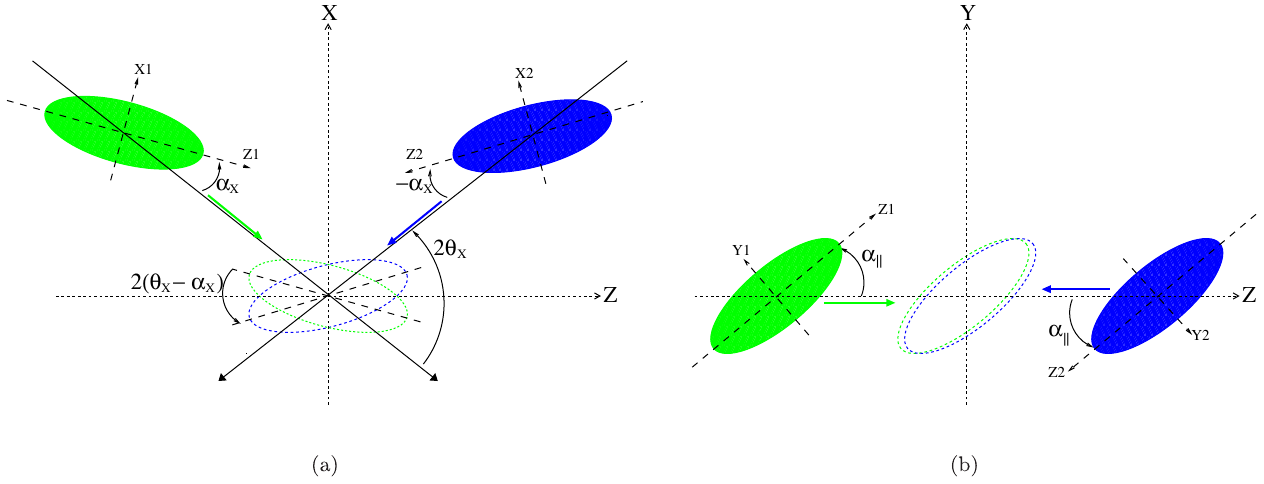
FIG. 1. Sketch of the four-dimensional collision footprint in the presence of a crossing angle, and with crab-cavities acting both in the crossing plane [crab-crossing configuration showed in (a)] and in the other transverse plane, the so-called parallel separation plane [crab- kissing configuration showed in (b)]. The hour-glass effect and the RF curvature of the crab-cavity deflecting field are not taken into account in these